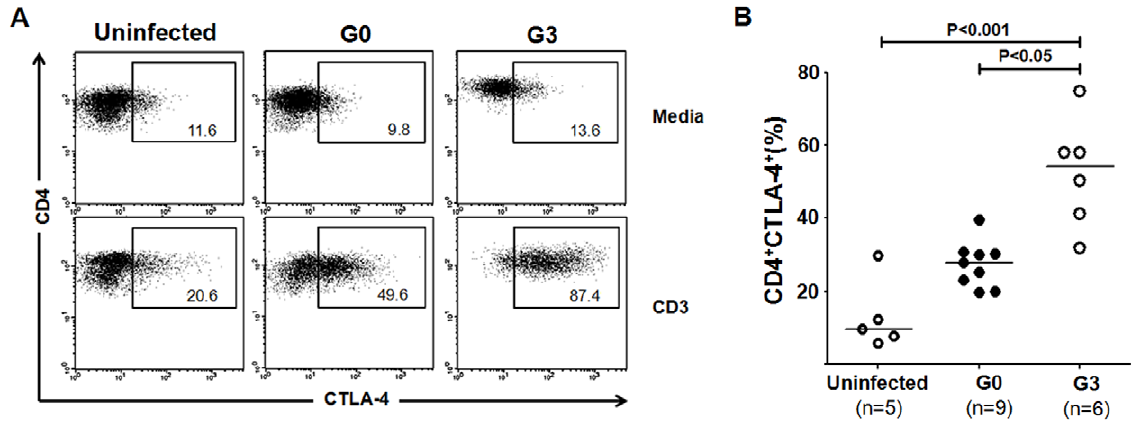
Figure 2. Increased frequencies of CD4 + CTLA-4 + T cells following polyclonal activation with anti-CD3 antibodies. PBMCs were stimulated with anti-CD3 for 18 h or media alone. Cells were surface stained with anti-CD4 monoclonal antibody followed by fixation and permeabilization and intracellular staining with anti-CTLA-4 monoclonal antibody. Lymphocytes were gated by forward and side light scatter. From this population single color CD4 staining histogram was made and CD4 + T cells were selected and analyzed for CD4 vs. CTLA-4 dot plot. (A) Representative dot plots from an uninfected control, an asymptomatic subject (G0) and a patient with severe cardiomyopathy (G3). The numbers in the quadrants represent percent cells in each out of total CD4 + T cells. (B) The frequency of induced CD4 + CTLA-4 + was calculated by subtracting the percentage of CD4 + CTLA-4 + T cells in unstimulated cultures from the percentage of CD4 + CTLA-4 + T cells responding to anti-CD3 stimulation. Values from individual uninfected controls, G0 or G3 subjects are depicted as separate points and median values are indicated by the horizontal lines. Kruskal-Wallis test with pairwise comparison was used to compare differences between subject groups.